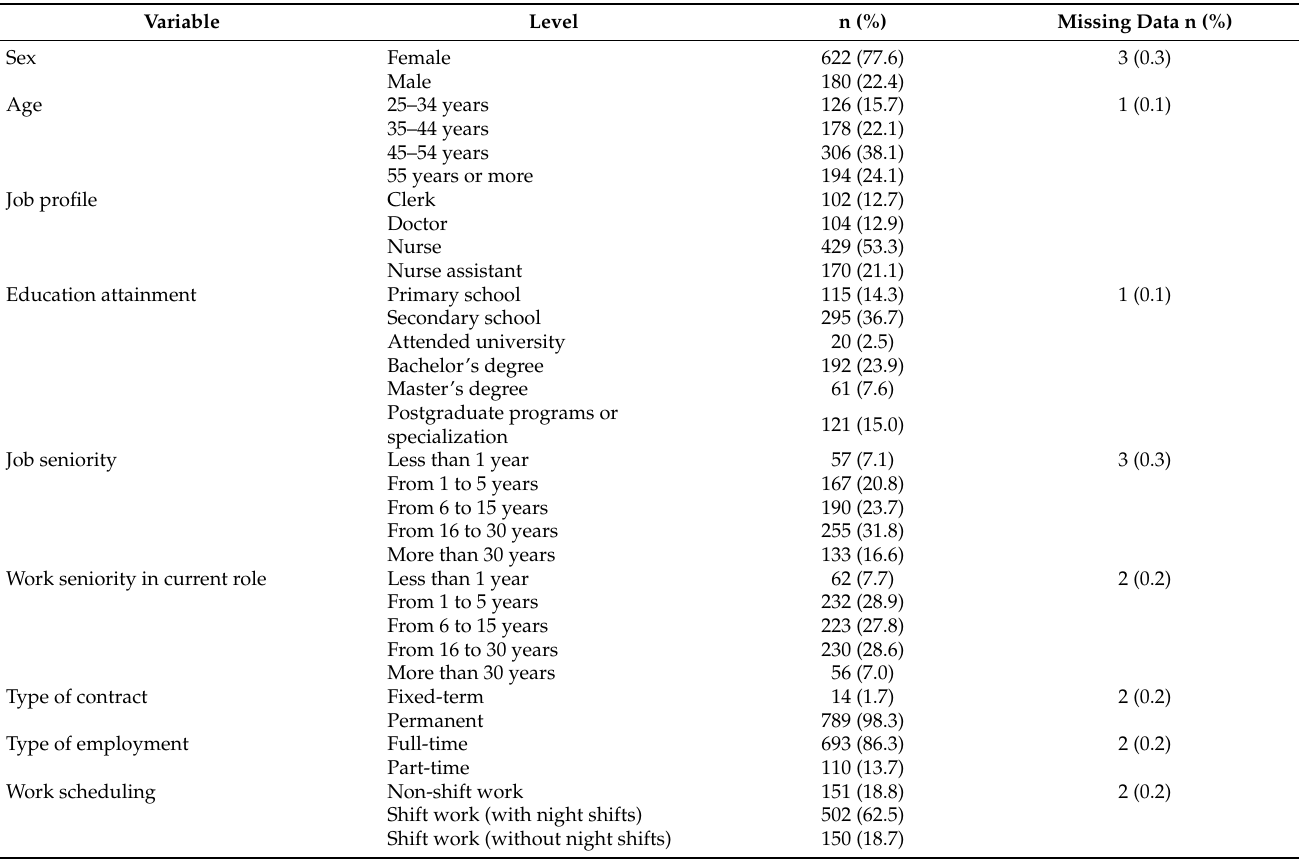
Table 1. Description of the participants in the pre-COVID-19 wave (n = 805).